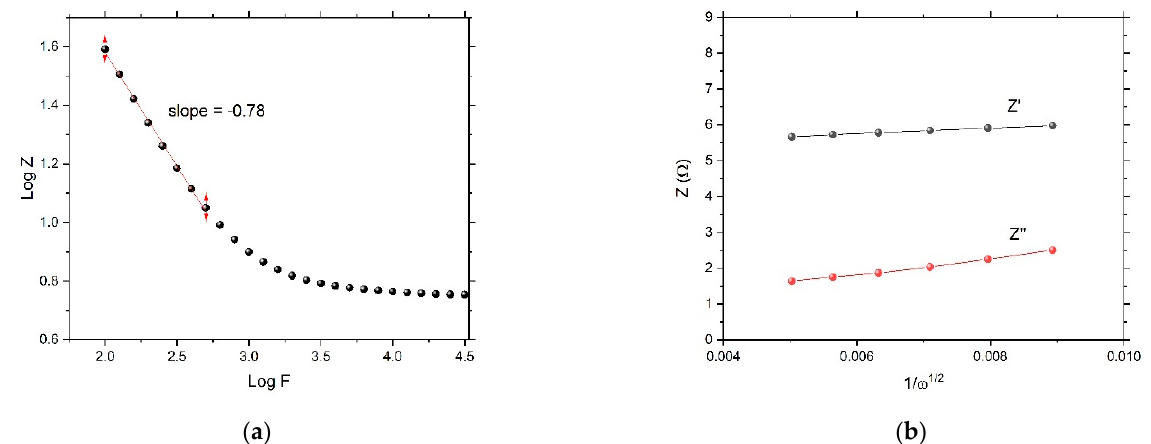
Figure 10. ( a ) Warburg Bode plot and ( b ) Warburg impedance plot.